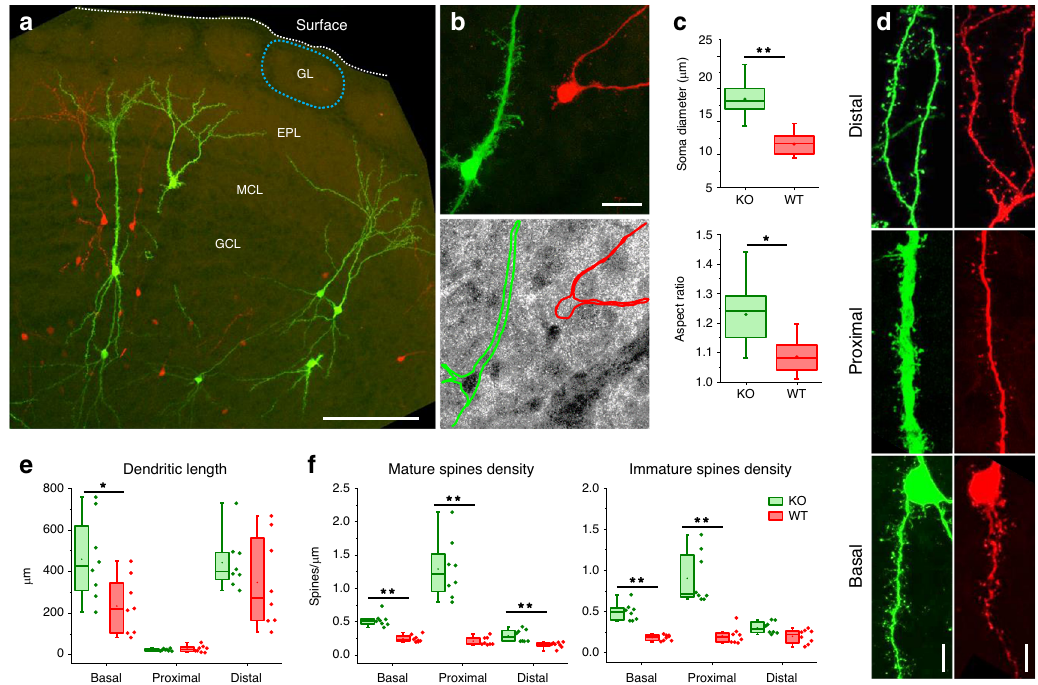
Fig. 5 PTEN-KO mosaic of olfactory granule cells generated postnatally. a Maximum intensity projection of a Pten fl ox KO mosaic in the olfactory bulb (GL = glomerular layer; EPL = external plexiform layer; MCL = mitral cell layer; GCL = granule cell layer). Scale bar 100 µ m. b Immunohistochemistry against PTEN con fi rms the loss of the protein upon Beatrix recombination (green = GFP; red = RFP; gray = PTEN). Scale bar 20 μ m. c The loss of PTEN caused the hypertrophy of the cell body and altered its morphology. d Representative images of basal, proximal and distal compartments from wild type and PTEN knockout granule cells. The images show how KO neurons exhibit a general increase in spine and fi lopodia density, with a marked phenotype in the proximal compartment. Scalebar 10 µ m. e The structure of the dendritic arborization is affected by the loss of PTEN as demonstrated by the length of the dendritic compartments. f Spine density is altered both for mature spines and for immature fi lopodia. Interestingly, this effect has a different spatial pattern than observed in pyramidal neurons. Statistical analysis for ( c ), ( e ) and ( f ) refers to n = 9 WT and n = 9 KO mice ( n spines = 1918 in WT, n = 6205 in KO; two-sided Mann – Whitney U test, * p < 0.05, ** p < 0.01; no adjustments were made for multiple comparisons). In ( c , e , f ) data are represented as box plots (see the section Statistics and reproducibility in “ Methods ” for a detailed